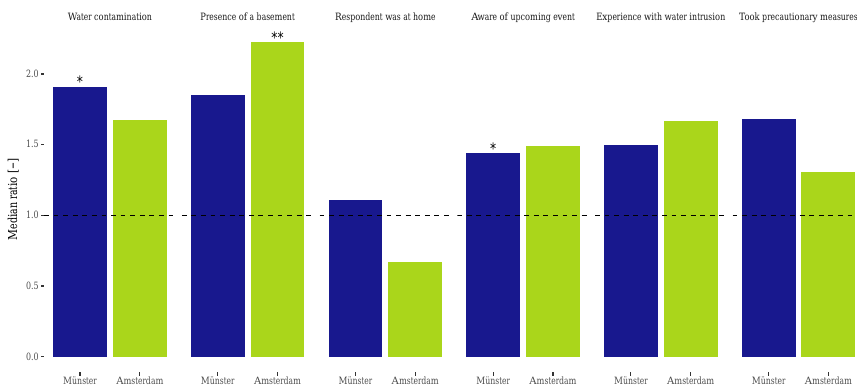
Figure 6. The effect of water contamination, presence of a basement in the building, presence of the respondent during the event, respondent’s awareness of the upcoming rain event, experience with water intrusion and precaution on the total damage ( N = 274, Münster; and N = 282, Amsterdam). Damage is expressed as the ratio between the median damage in the group of respondents where variable value is true and the median damage in the group of respondents where variable value is false . A median ratio above 1 means a positive correlation and below 1 means a negative correlation. A significant difference between medians, based on a bootstrapping method with 10000 bootstrap samples, is denoted as follows: ∗ = p < 0 . 05, ∗∗ = p < 0 . 01, ∗∗∗ = p < 0 . 001